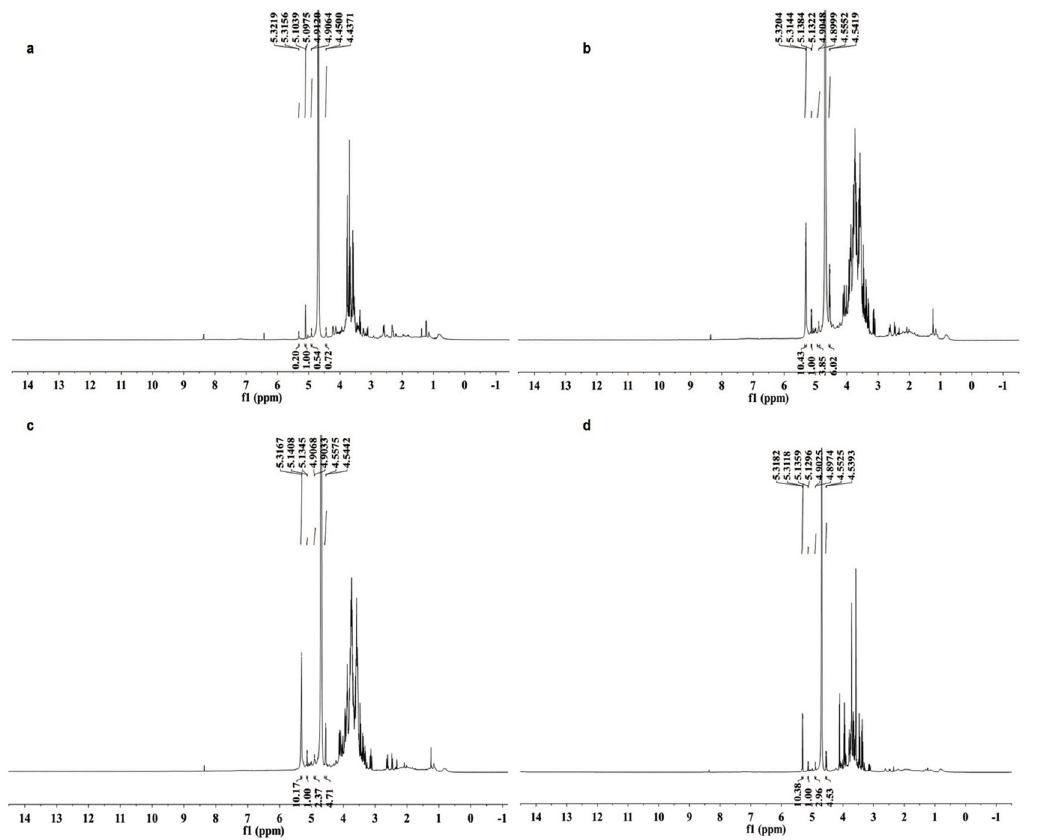
Figure 2. 1 H-NMR spectra (600 MHz, D 2 O, 27 °C) of four polysaccharides from Armillaria mellea . ( a ) SP; ( b ) CMP; ( c ) CFMP; ( d )